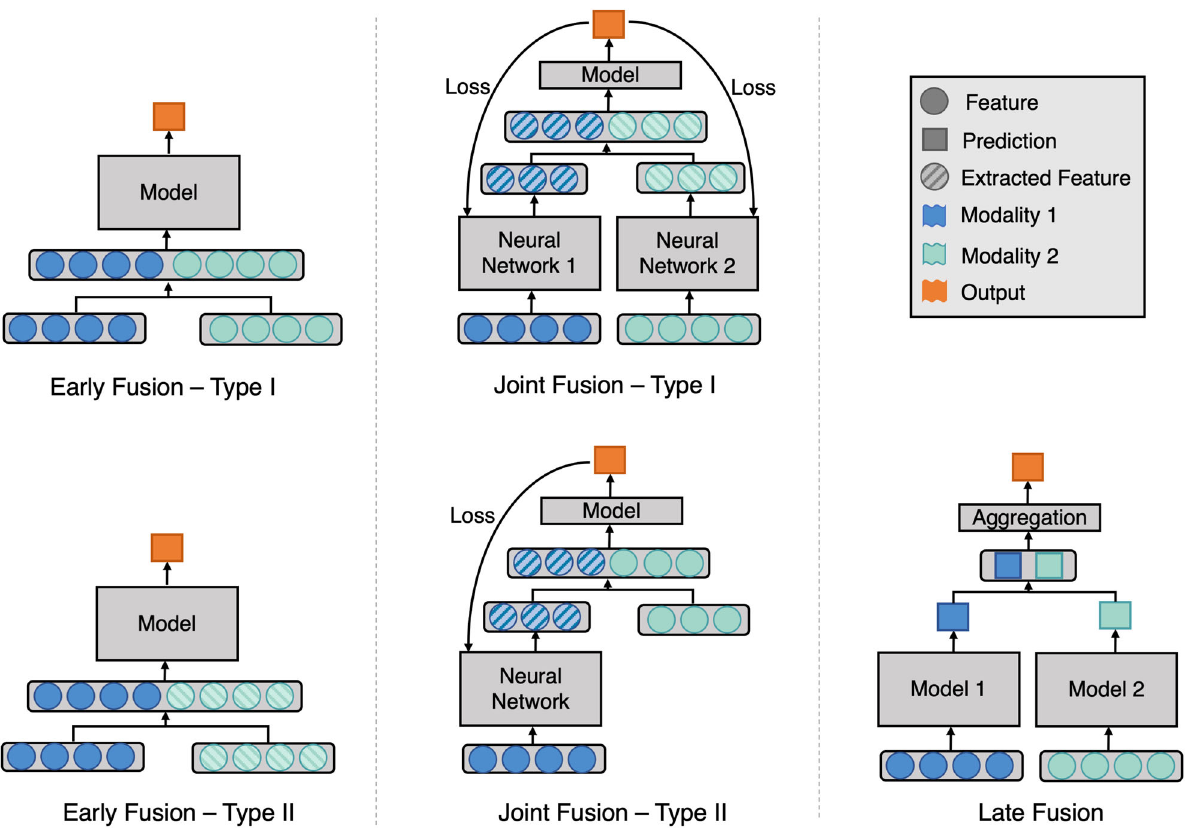
Fig. 2 Fusion strategies using deep learning. Model architecture for different fusion strategies. Early fusion (left fi gure) concatenates original or extracted features at the input level. Joint fusion (middle fi gure) also joins features at the input level, but the loss is propagated back to the feature extracting model. Late fusion (right fi gure) aggregates predictions at the decision